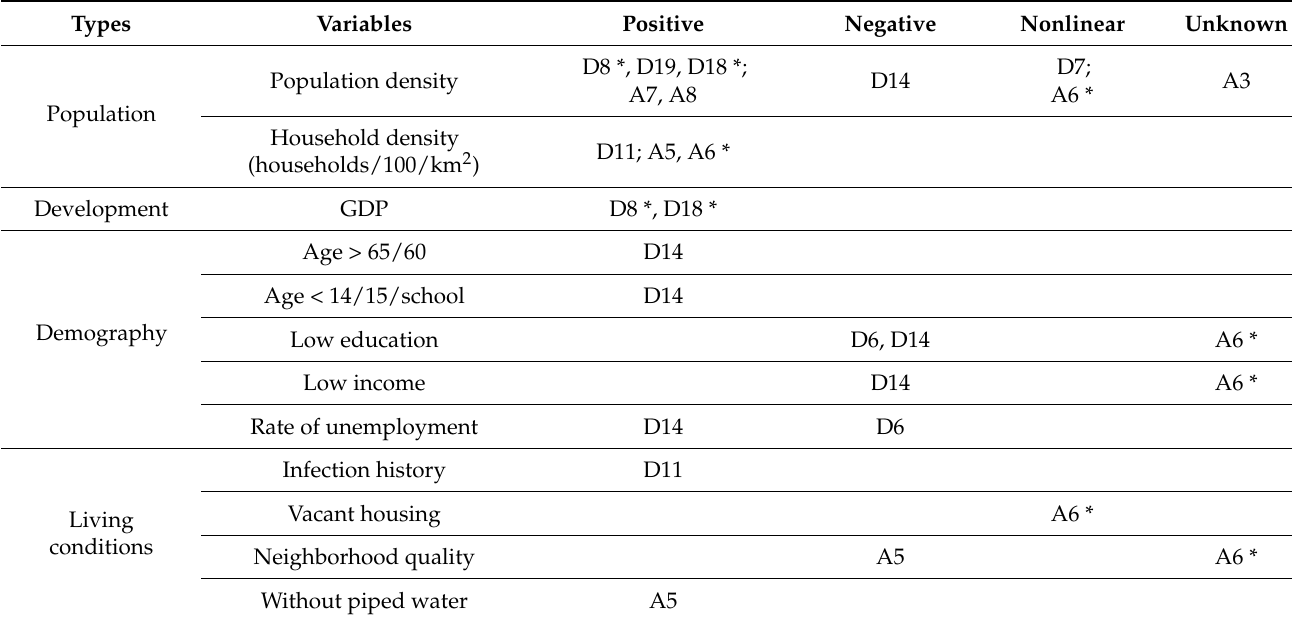
Table 5. Effect of socio-economic variables on dengue-related